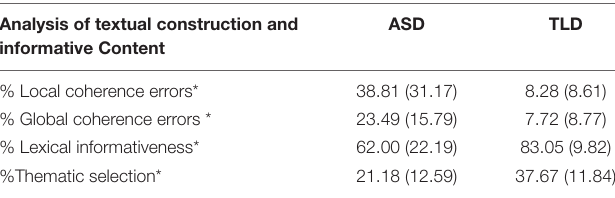
TABLE 4 | Results of the analysis of textual organization and informative content on the narrative production task in the groups of participants with ASD and TLD. Analysis of textual construction and informative